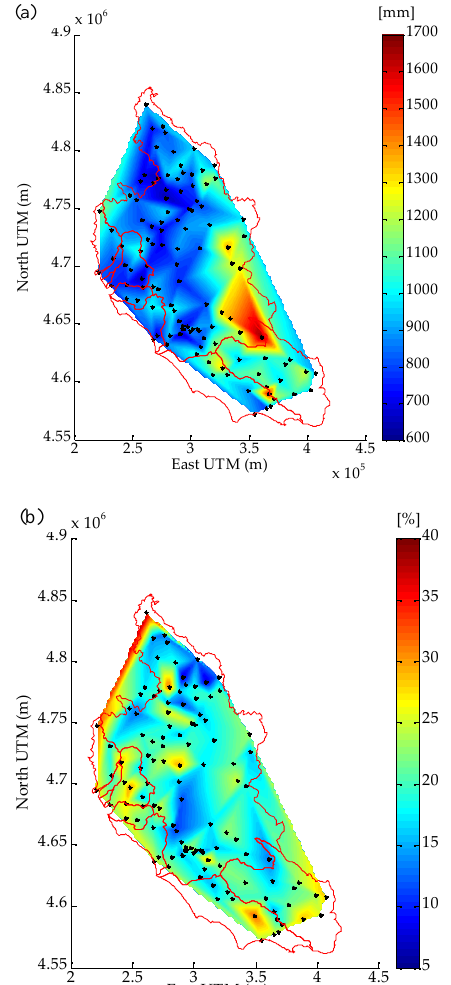
Fig. 3. Geographical representation of the mean annual precipi- tation MAP (a) and of the coefficient of variation CV of annual precipitation (b) . The black points represent the locations of rain gauges in the